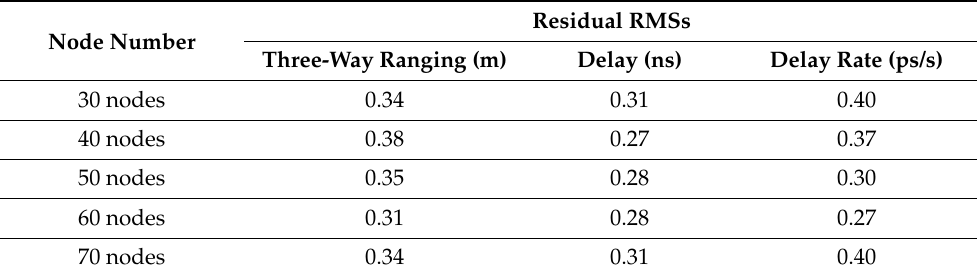
Table 1. Residual RMSs of ranging, delay and delay rate by selecting different nodes in the method based on B-spline function during